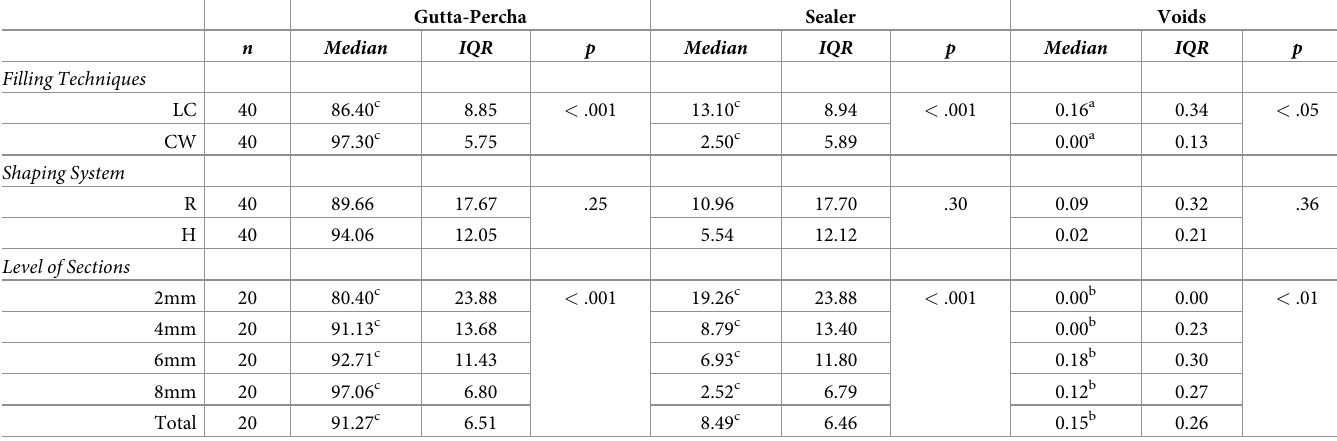
that there were significant differences between cold lateral condensation and continuous wave obturation techniques by percentages of gutta-percha, sealer and voids at each level indepen- dent from shaping systems ( p < 0.05). Continuous wave technique had significantly higher gutta-percha and lower sealer and void percentages than lateral condensation technique on average in all sections. However, there were no statistically significant differences in the per- centages of gutta-percha, sealer and voids between Reciproc Blue and Hyflex EDM systems at any level ( p > 0 . 05 ). Also, for the percentages of gutta-percha, sealer and voids; the difference between the level of sections (2mm, 4mm, 6mm, 8 mm and total) was significant irrespective of filling techniques ( p < 0.05). 2-mm sections had significantly less gutta-percha and more sealer compared with 4, 6 and 8 mm sections ( p < 0.05). The highest percentages in gutta-per- cha and lowest in sealer was at 8-mm level of sections. 4 mm level of sections showed the high- est and 2 mm level of section showed the lowest voids percentages. Tables 2, 3 and 4 show all descriptive statistics for the variables and p values for all group differences in C1-type.